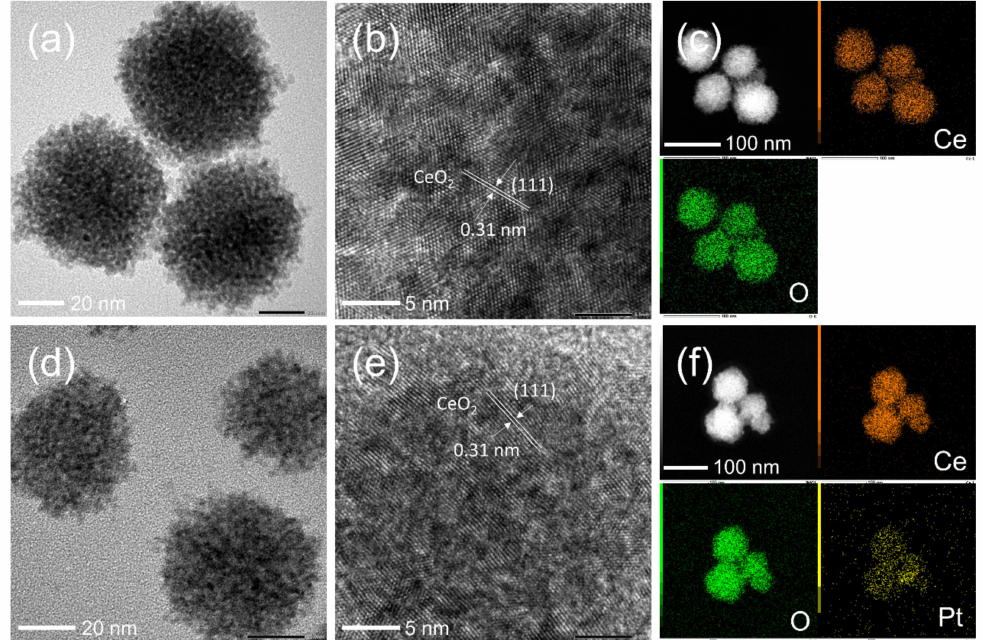
Figure 4. TEM images of ( a ) CeO 2 -NS and ( d ) Pt/CeO 2 -NS; HRTEM images of ( b ) CeO 2 -NS and ( e ) Pt/CeO 2 -NS; EDS elemental mappings of ( c ) CeO 2 -NS and ( f ) Pt/CeO 2